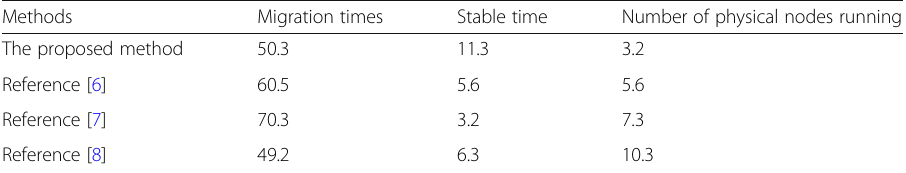
Table 1 Performance comparison results Methods Migration times Stable time Number of physical nodes running The proposed method